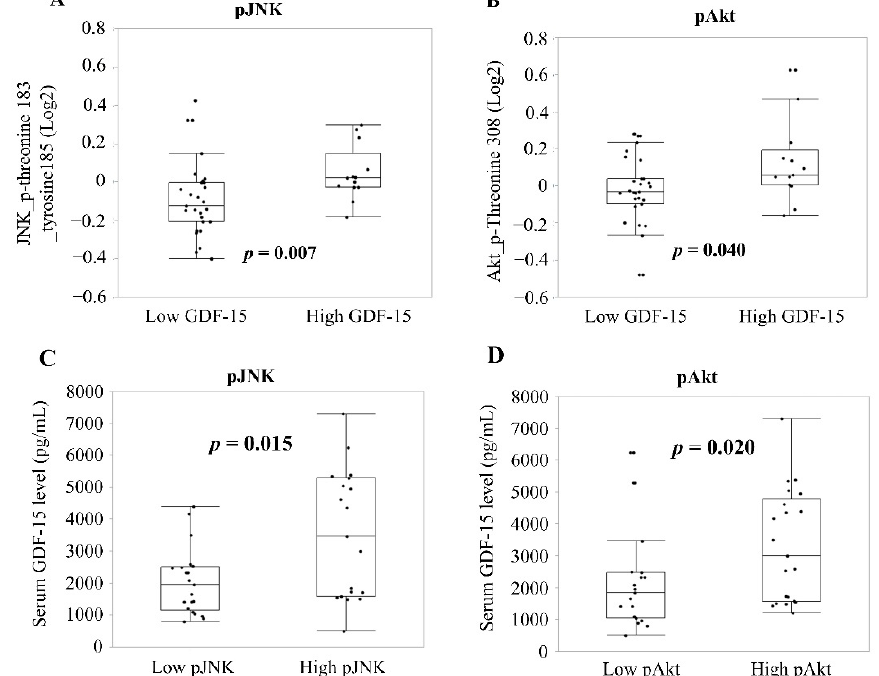
Figure 5. Tumor protein expression associated with serum GDF-15 levels by RPPA. Tumor protein expressions of ( A ) pJNK and ( B ) pAkt, represented as a binary logarithm, were compared among patients in the low- and high-GDF-15 groups. Serum GDF-15 levels, represented as logGDF-15, were compared among patients with high and low protein expressions of ( C ) pJNK and ( D ) pAkt in the tumor. Boxes indicate 5th and 95th percentiles. pJNK, phospho-JNK; pAkt, phospho-Akt.